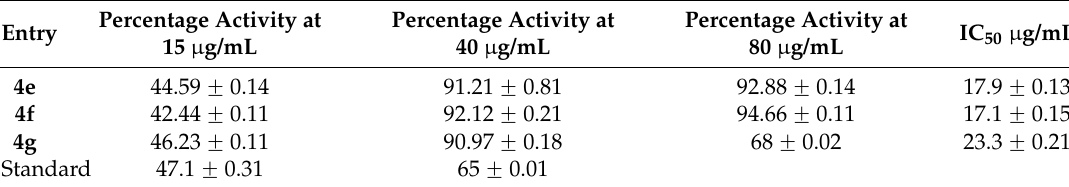
Table 6. Urease inhibition studies of 5-arylthiophene-2-sulfonylacetamides 4e – g